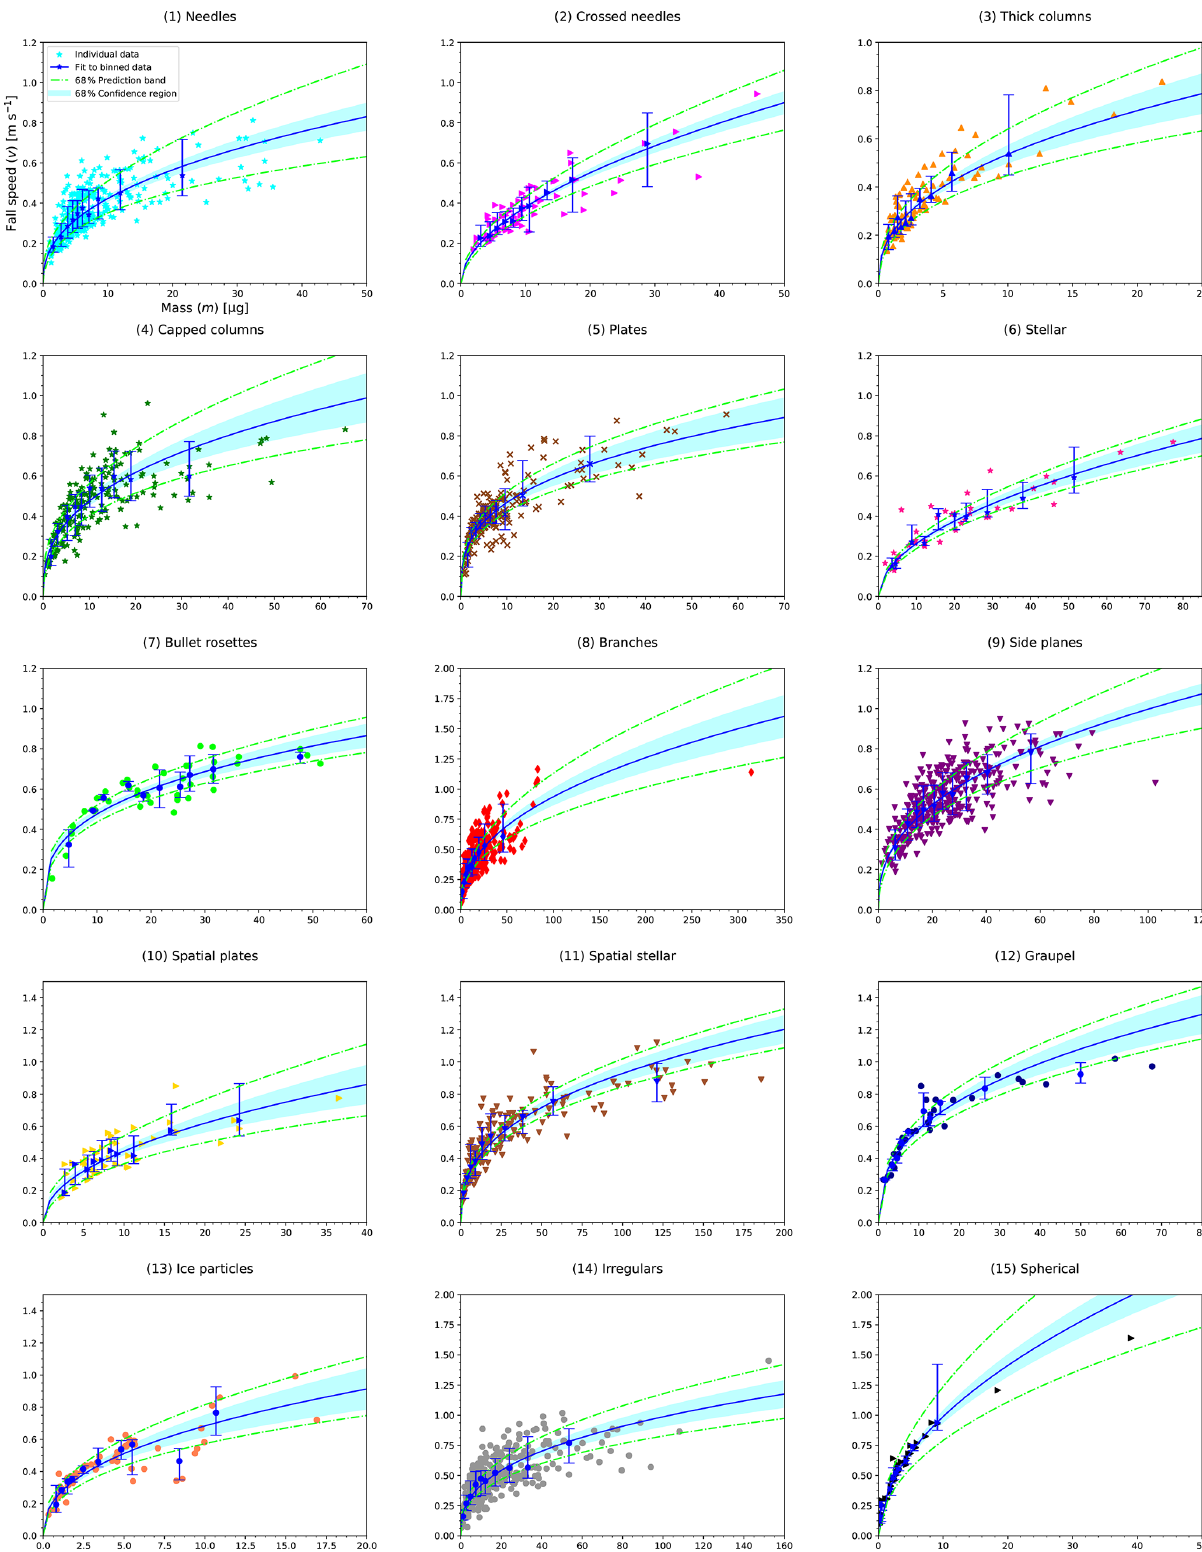
Figure A3. Same as Fig. A1, but fall speed vs. mass ( v vs. m ) relationships given by Eq. (10) are shown here.